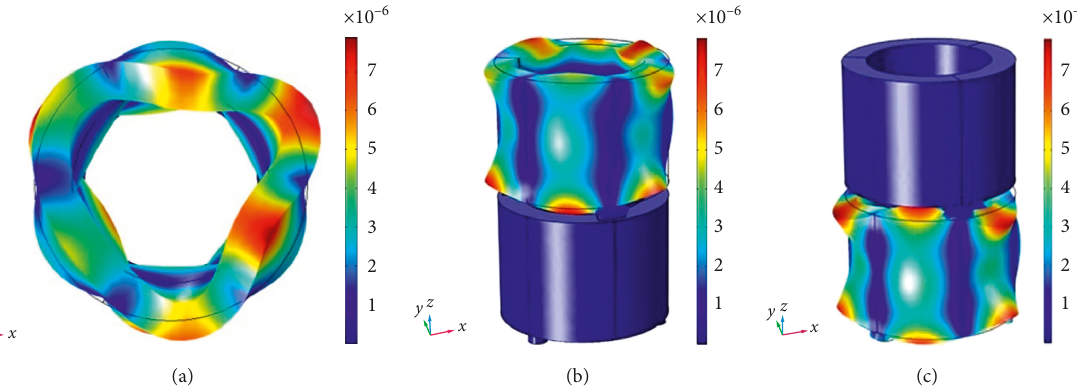
Figure 5: Vibration modes of the cylinder-type actuator when the upper cylinder is excited at 81.55 kHz (a, b) and the lower cylinder is excited at 80.90kHz (c).